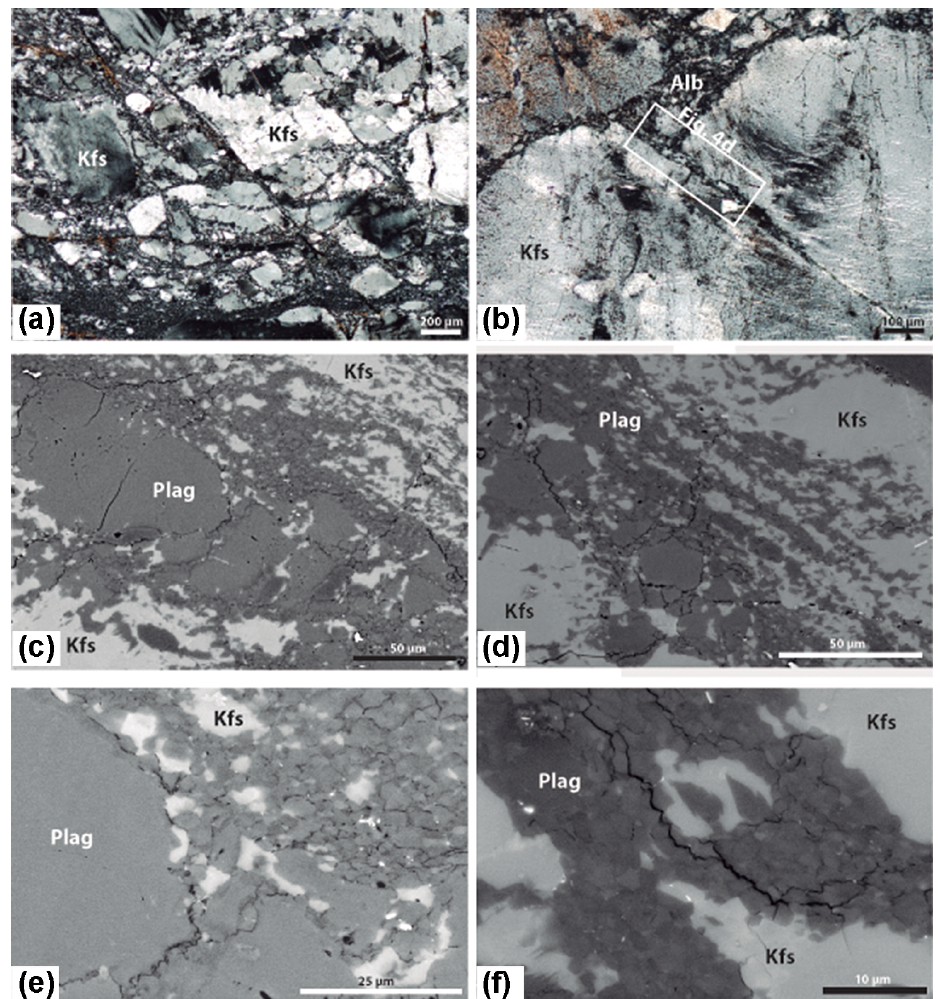
Figure 4. BSE images of microstructures of feldspar porphyroclasts: (a) cataclastic texture generated by fracturing and further disaggregation of feldspar porphyroclasts into fragments with heterogeneous grain size; (b) intracrystalline fractures in feldspar porphyroclast filled by fine- grained two-feldspar mixtures; (c) set of parallel fractures cutting plagioclase porphyroclast; (d) detail of Fig. 4b showing the filling of a feldspar fracture; (e) tail of fine-grained plagioclase + K-feldspar around plagioclase porphyroclasts; (f) detail of the feldspar fracture showing the infill by an almost pure plagioclase aggregate.